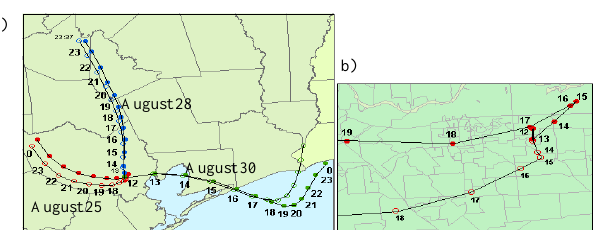
Figure 4. (a) STOPS trajectories starting from the industrial sub- domain. Trajectories determined based on the winds in the STOPS middle column are indicated by filled circles, and those determined based on the average winds in the whole STOPS domain with open circles. Trajectories for 25 August are indicated with red dots, those for 28 August with blue dots, and those for 30 August with green dots. Numbers next to dots show UTC time (b) details of the trajec- tory on 25